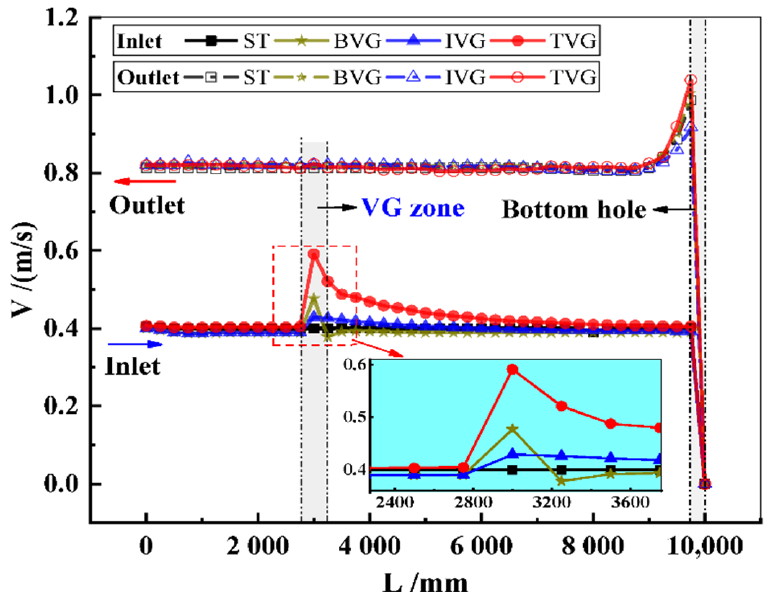
Figure 9. Velocity variation curves along the well’s depth in the injection channel and production channel of the four heat exchangers.